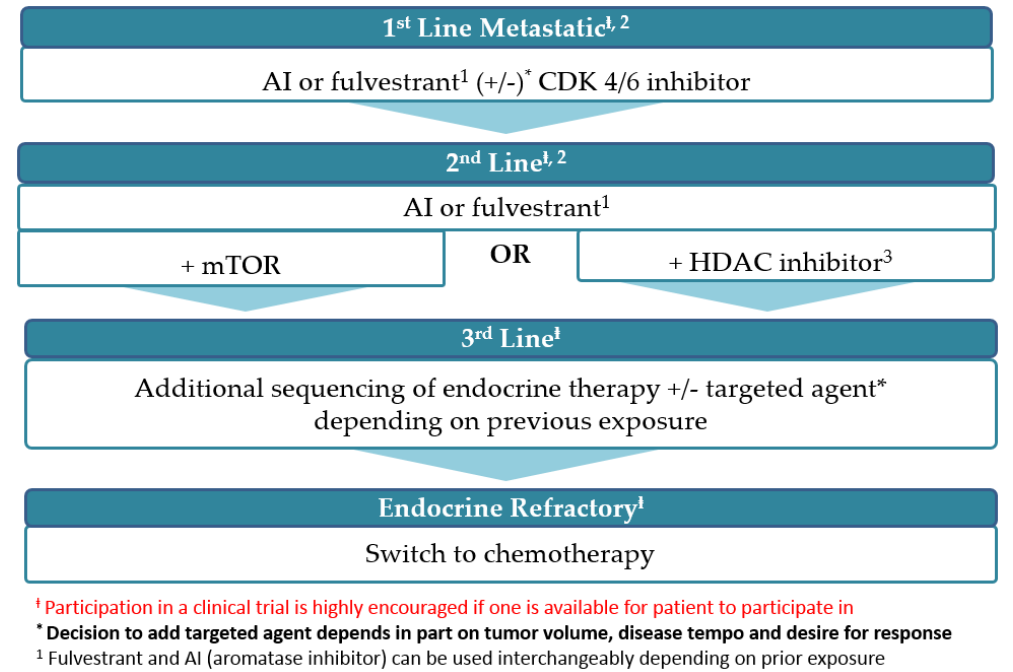
Figure 2. Proposed sequencing strategy for postmenopausal patients with ER+/HER2 − advanced breast cancer.